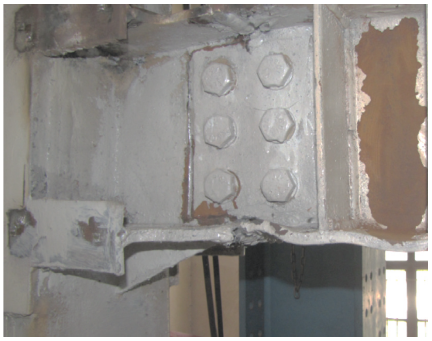
Figure 8: The failure mode in the test.